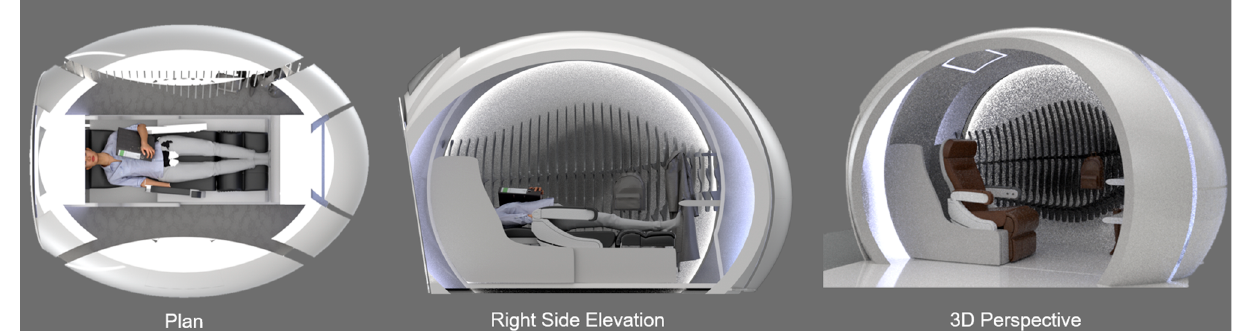
Figure 2. Elevation and sections illustrating the different seat positions: Seated Upright Position, Zero Gravity Position, and Napping Position in the “Reviving Pod” (design by the authors).